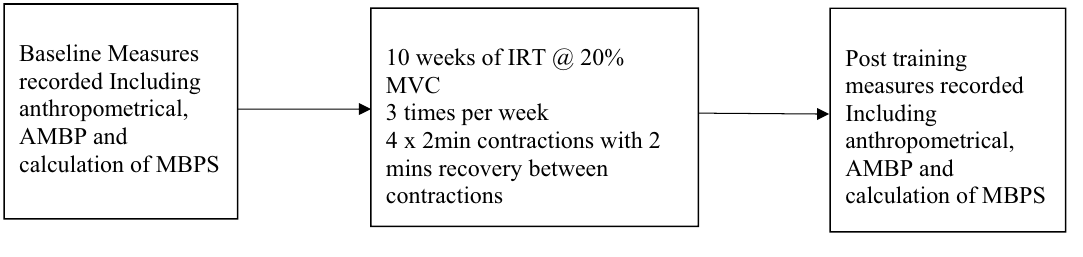
Figure 1. Summary of the IRT protocol and pre/post